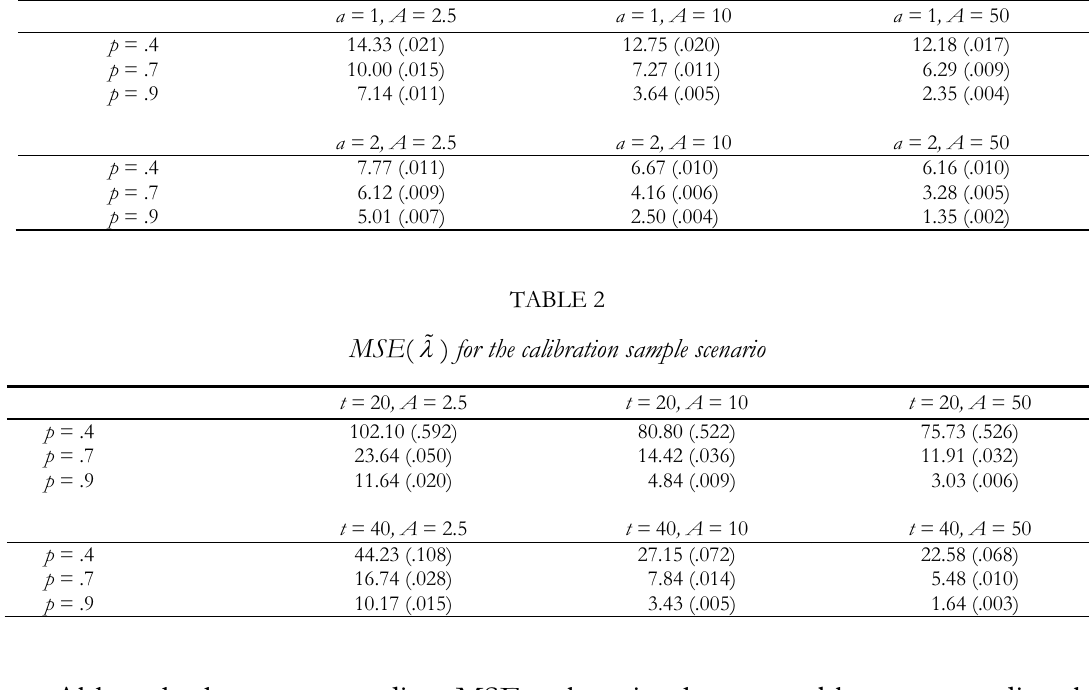
ˆ MSE ( (cid:79) ) for the training sample scenario a = 1 , A = 2.5 a = 1 , A = 10 a = 1 , A = 50